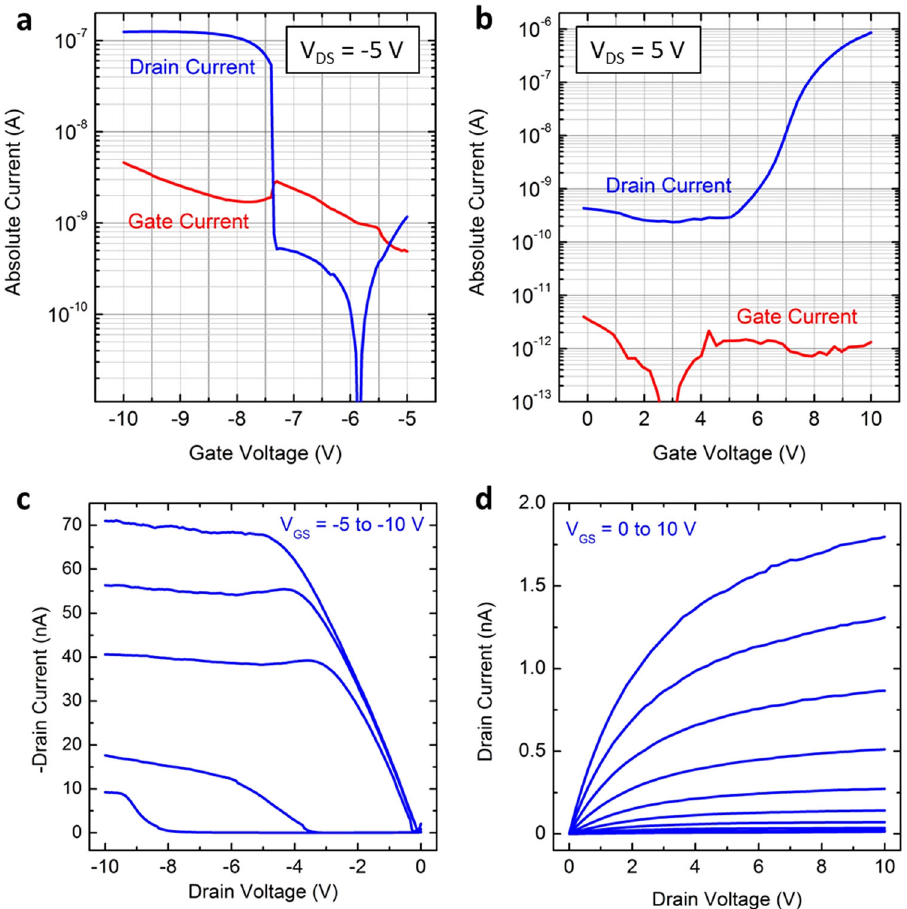
Fig. 3 Electric measurement results of liquid-Si-based TFTs produced on paper. a Transfer properties of PMOS TFT at a drain voltage of − 5 V, showing both the drain current (blue), as well as the leakage current (orange). b Transfer properties of the NMOS TFT with a drain voltage of 5 V. c Output properties of the PMOS TFT with gate voltage ranging from − 5 to − 10 V in steps of 1.25 V. d Output properties of the NMOS TFT with gate voltages ranging from 0 to 10 V in steps of 1 V. All devices had a channel size of 50×50 μ m. (Panels a and b reproduced, with permission, from ref.